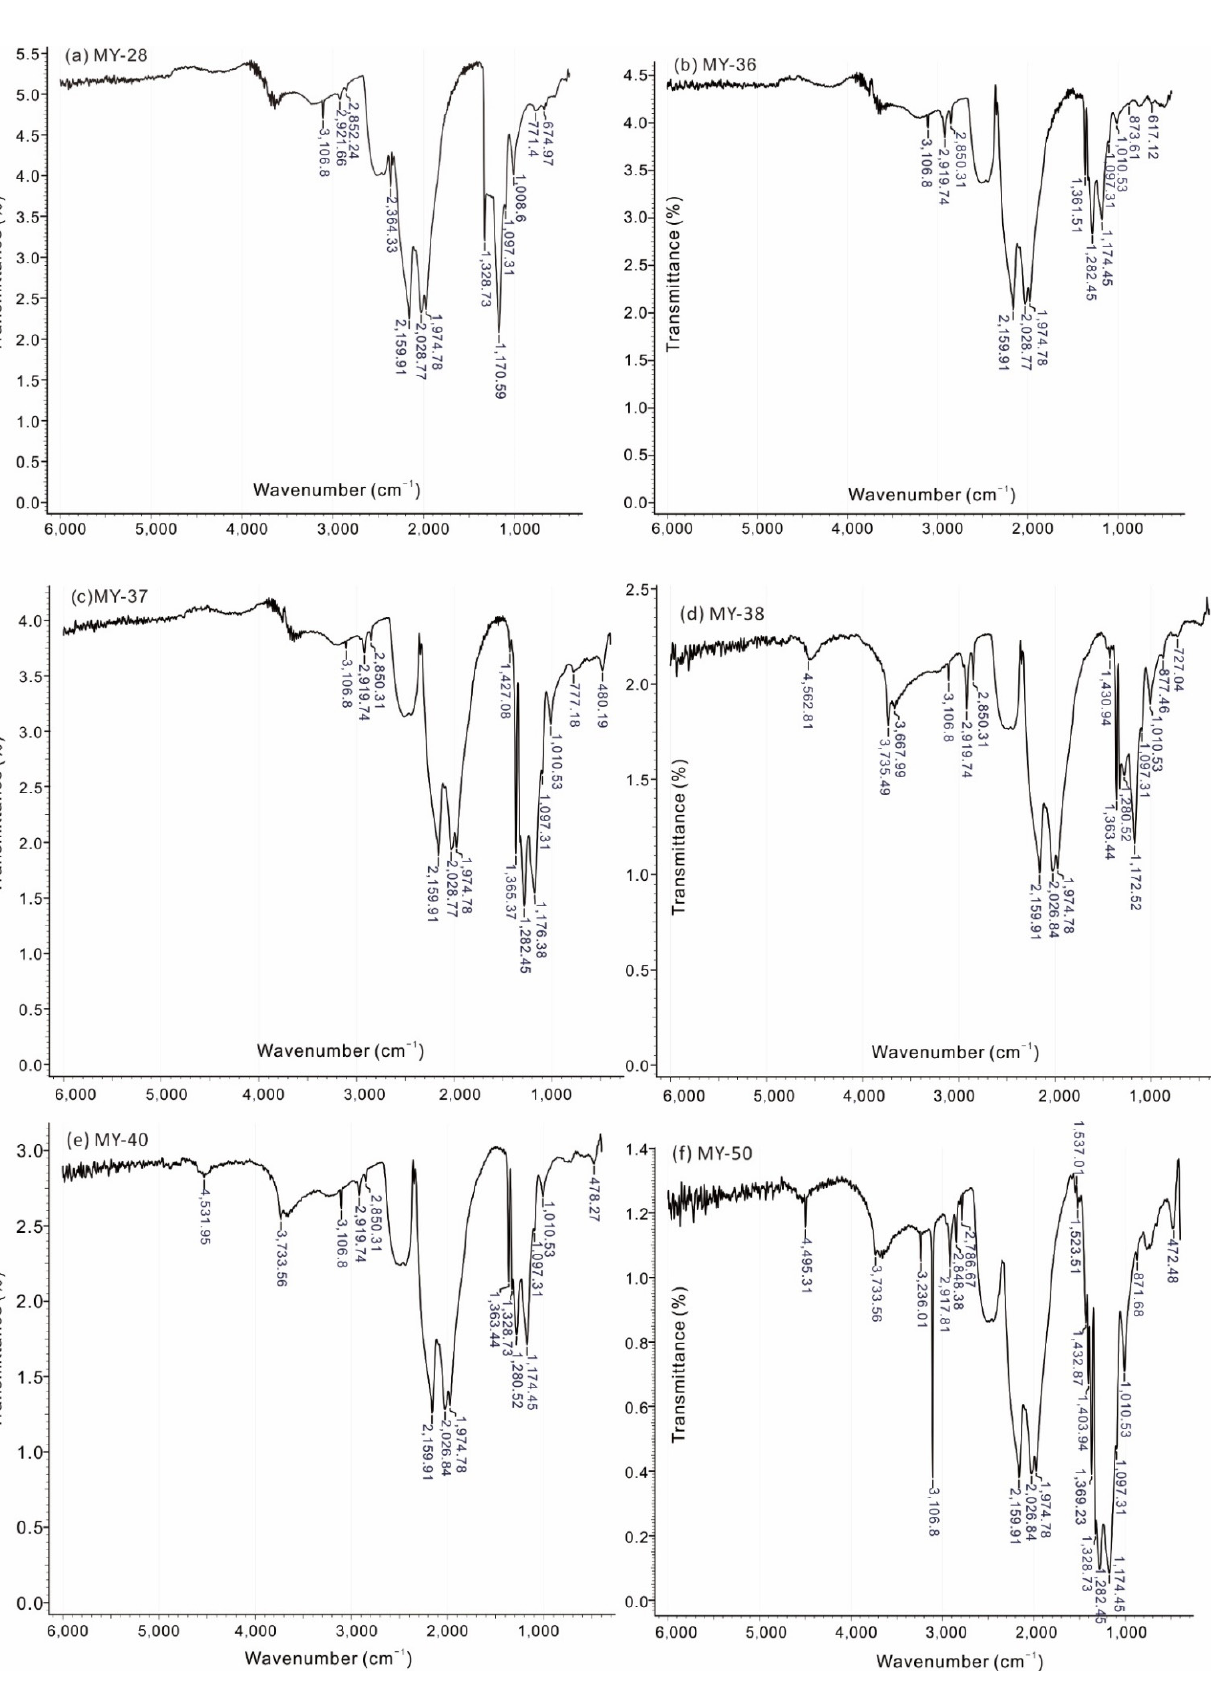
Figure 4. IR Spectra of representative brown diamonds from the Mengyin deposit.